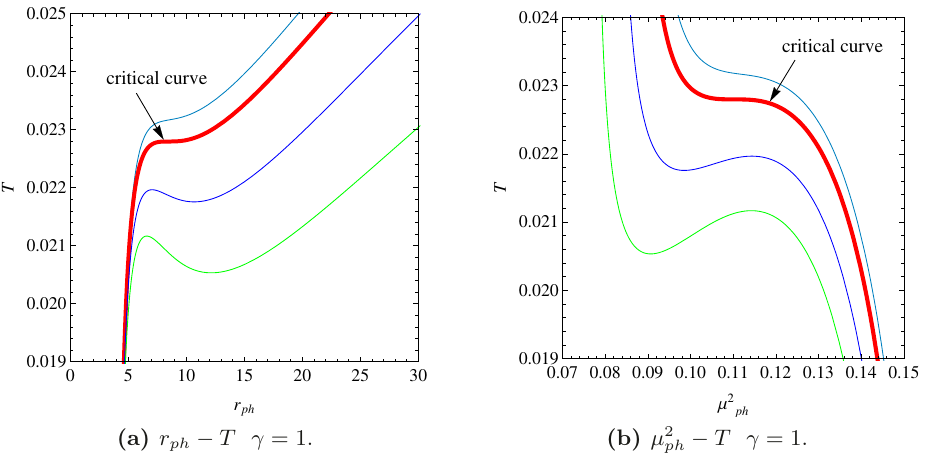
0 . 0002 to P c + 0 . 00004 −